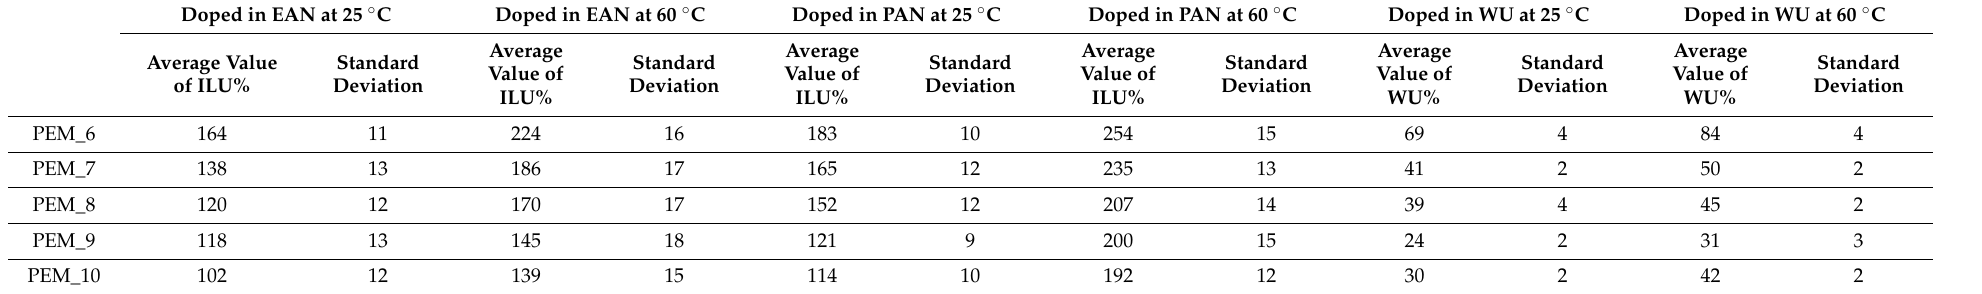
Table 4. Uptake values of PEM_6–PEM_10 membranes.